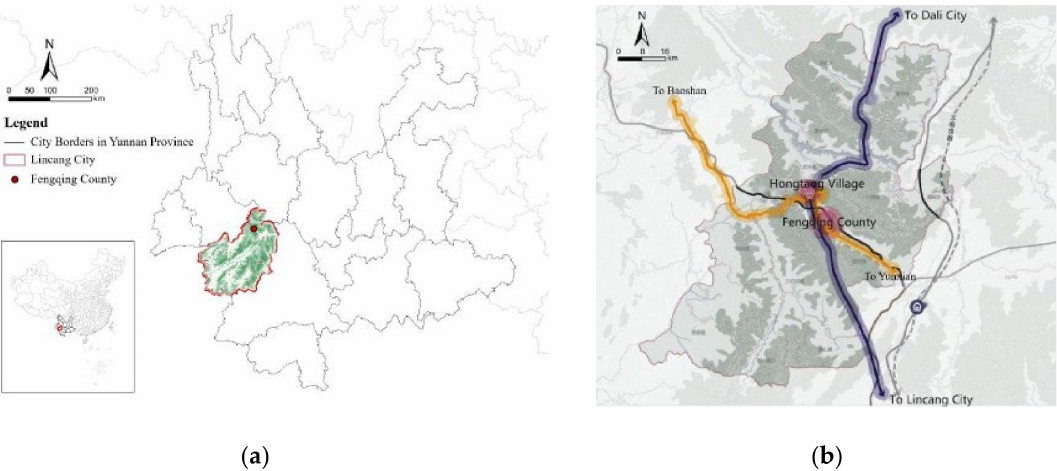
Figure 2. The location of Hongtang village in Fengqing country in Yunnan Province. ( a ) Lincang City in Yunnan Province; ( b ) Hongtang village in Fengqing County. Source: the